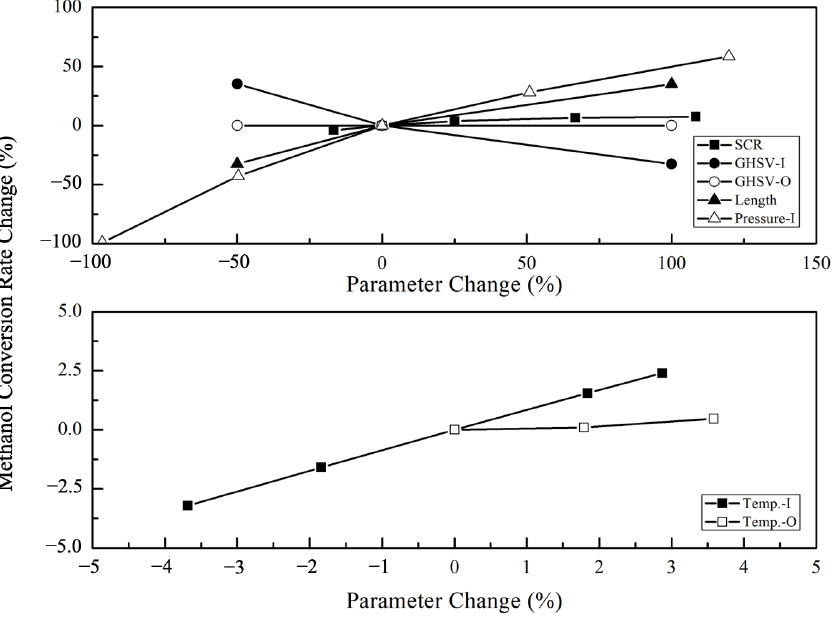
Figure 7. Sensitivity analysis of the methanol–steam-reforming reactions.